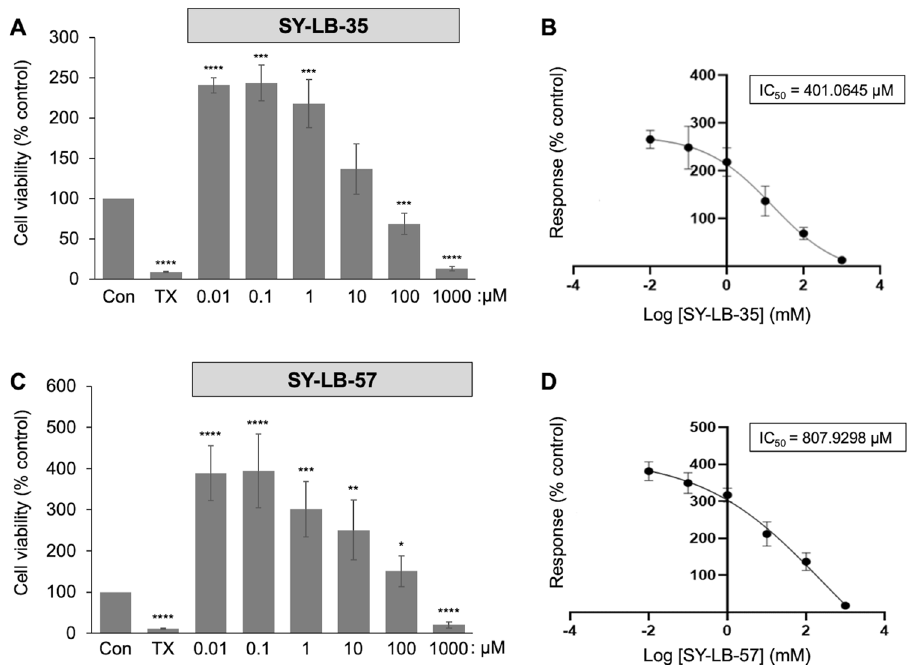
Figure 3. Significant increases in C2C12 cell viability are stimulated by SY-LB-35 or SY-LB-57. C2C12 cells were serum-starved overnight and treated with the indicated concentrations of SY-LB-35 ( A ) or SY-LB-57 ( C ) for 24 h. Treatments with Triton X-100 (TX, 125 µM) was used as negative control for viability in the MT Glo assay. Cell viability is presented as a percent of luminescence detected in control, untreated cells. ( A ) Treatment of C2C12 cells with SY-LB-35 at 100 µM and 1 mM significantly reduced cell viability when compared to control cells (69%, ***p < 0.001 and 13%, **** p < 0.0005%; respectively). In contrast, at lower concentrations of 0.01 µM, 0.1 µM and 1 µM, the cell viability was significantly increased (241%, **** p < 0.0005; 244%, and 218%, *** p < 0.001, respectively). Cell viability measured at 10 µM SY-LB-35 was not different from control (137%). Data are expressed as mean ± SEM (n = 3) with each experiment performed in triplicate. ( B ) Non- linear regression analysis reveals an IC 50 value of 401.0645 µM for SY-LB-35. ( C ) Treatment of C2C12 cells with SY-LB-57 at 1 mM reduced cell viability significantly (20%, **** p < 0.0005). Significant increases in cell viability were observed in response to all other concentrations tested (0.01 µM: 390%; 0.1 µM: 394%, **** p < 0.0005; 1 µM: 301%, *** p < 0.001; 10 µM: 251%, ** p < 0.01; 100 µM: 151%, * p < 0.05). Data are expressed as mean ± SEM (n = 3) with each experiment performed in triplicate. ( D ) Non-linear regression analysis reveals an IC 50 value of 807.9298 µM for